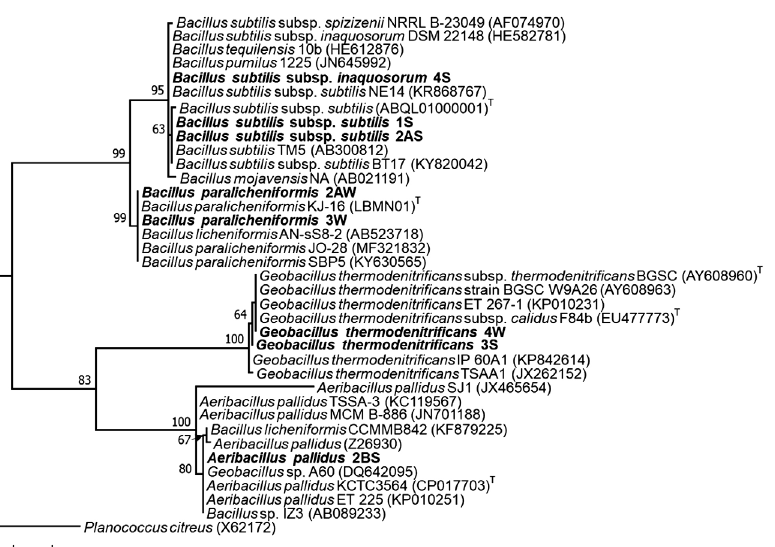
Fig. 4. Maximum likelihood phylogenetic tree of partial sequences of 16S rRNA gene. The strains isolated in the present study are indicated as bold. T denotes “type species”. Bootstrap values >50 are only mentioned on the branch of the